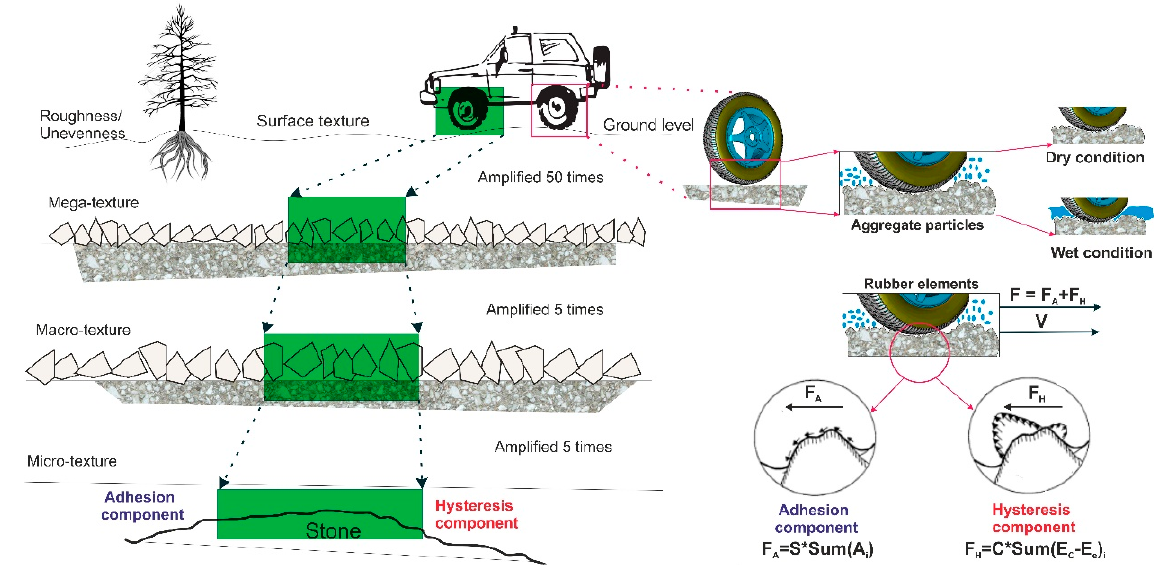
Figure 4. A typical schematic of the rubber-tire and pavement surface interaction components.